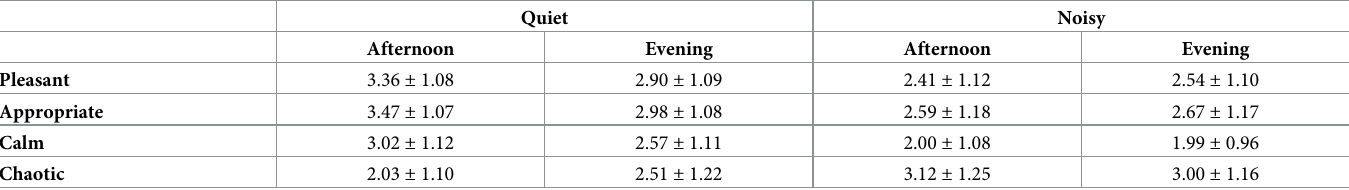
Table 9. Means and SE for scales with significant interaction effect between location and time in the laboratory (N =